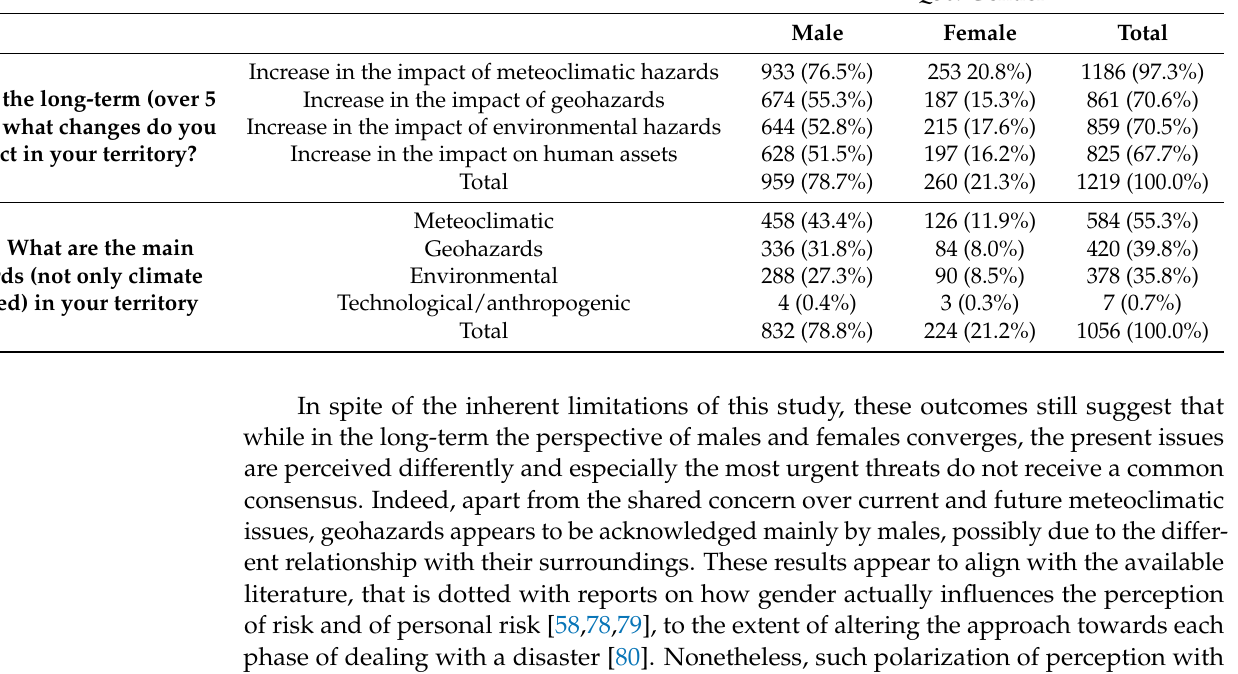
Q30: Gender Male Female Total